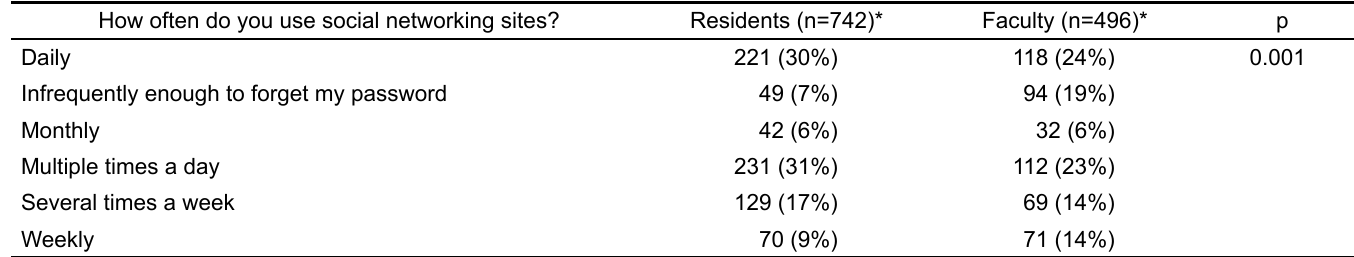
Table 2. Frequency of personal use of social media networking sites by faculty and residents.